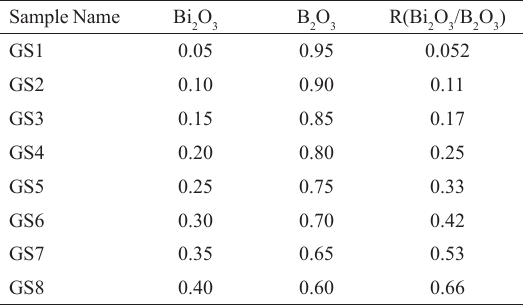
Table 1: Chemical compositions and R value (Bismuth to Borate ratio)